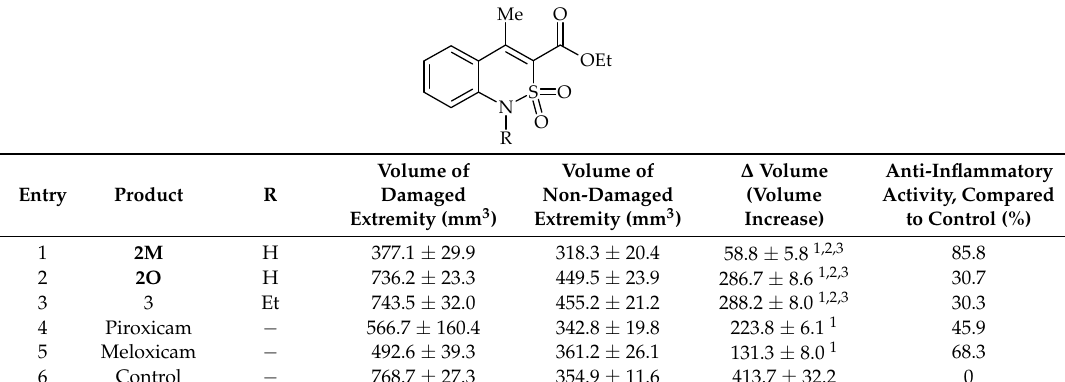
Table 2. The anti-inflammatory activity of esters 2M , 2O , 3 , and reference drugs.